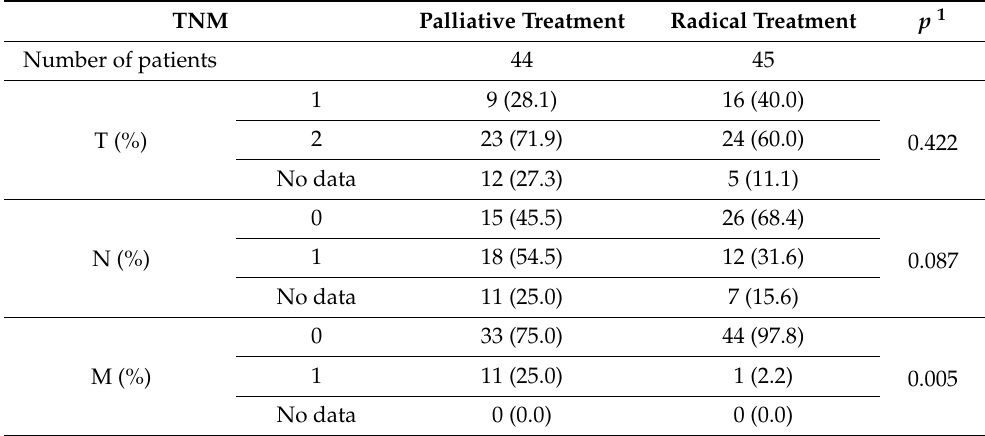
Table 4. TNM clinical characteristics of 89 patients diagnosed with primary tracheal cancer by treatment intention. TNM Palliative Treatment Radical Treatment p 1 Number of patients